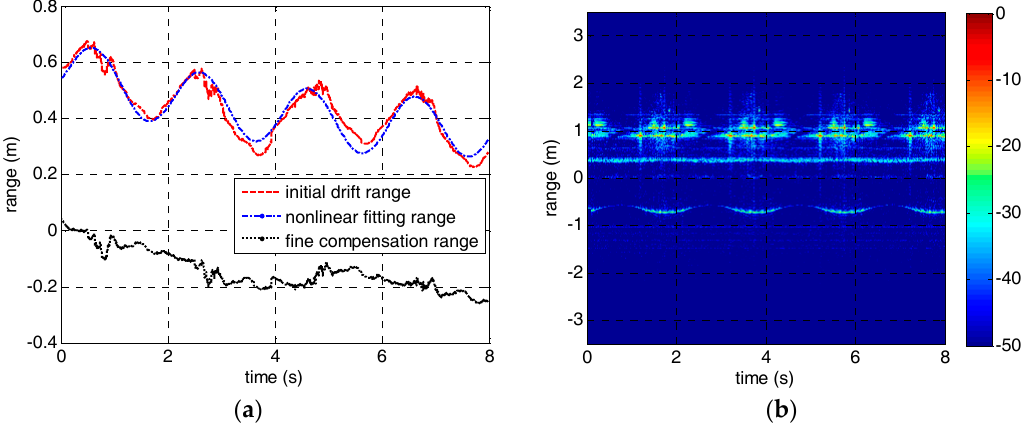
Figure 9. The nonlinear fitting result and the HRRP of the precession warhead model after drift error correction. ( a ) The nonlinear fitting result. ( b ) The HRRP of the warhead model.